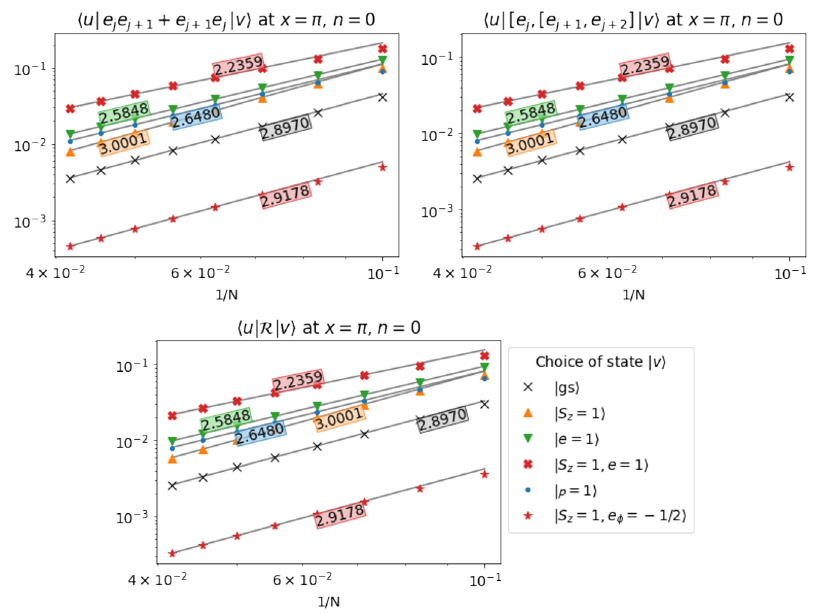
Figure 10 . Absolute value of matrix elements, plotted using the same conventions as in (cid:12)gure 3 up to the choice of j u i : for each state j v i the state j u i is taken to be the (cid:12)rst excited energy state corresponding to the same choice of lattice parameters that were used for j v i . (We recall that j v i is taken to be the lowest-energy state). In the lowest plot R is as de(cid:12)ned in